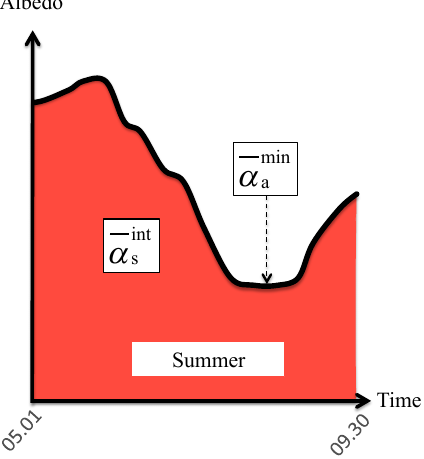
Figure 2. Schematic of a typical albedo cycle over one summer, dis- playing parameters which have been linked to annual and summer (between 1 May and 30 September in the Northern Hemisphere) SMB. α int s is retrieved using Eq. (1). The summer minimum value of albedo is represented by α min a